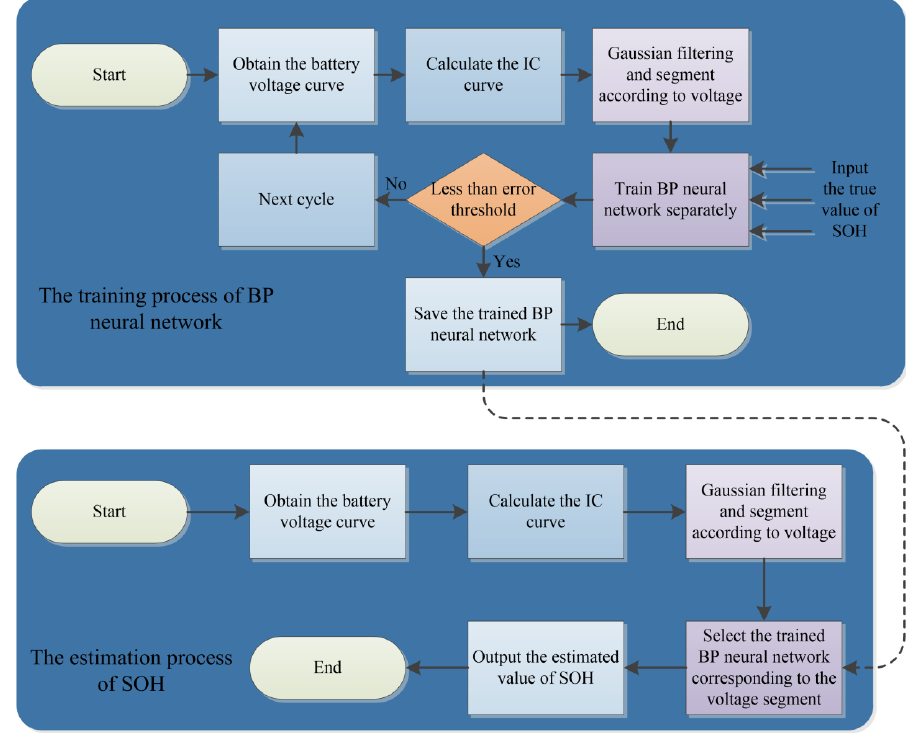
Figure 5. The process of the proposed SOH estimation method.